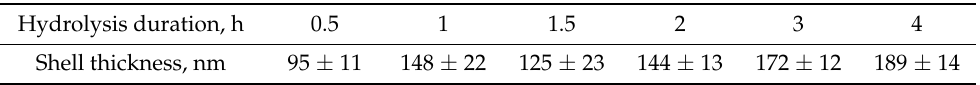
Figure 4. SEM images of core–shell particles obtained in the processes with 4 h hydrolysis duration. Table 1. The mean thickness with the confidence interval ( p = 0.9) of the silica shell, measured from the hydrolysis duration